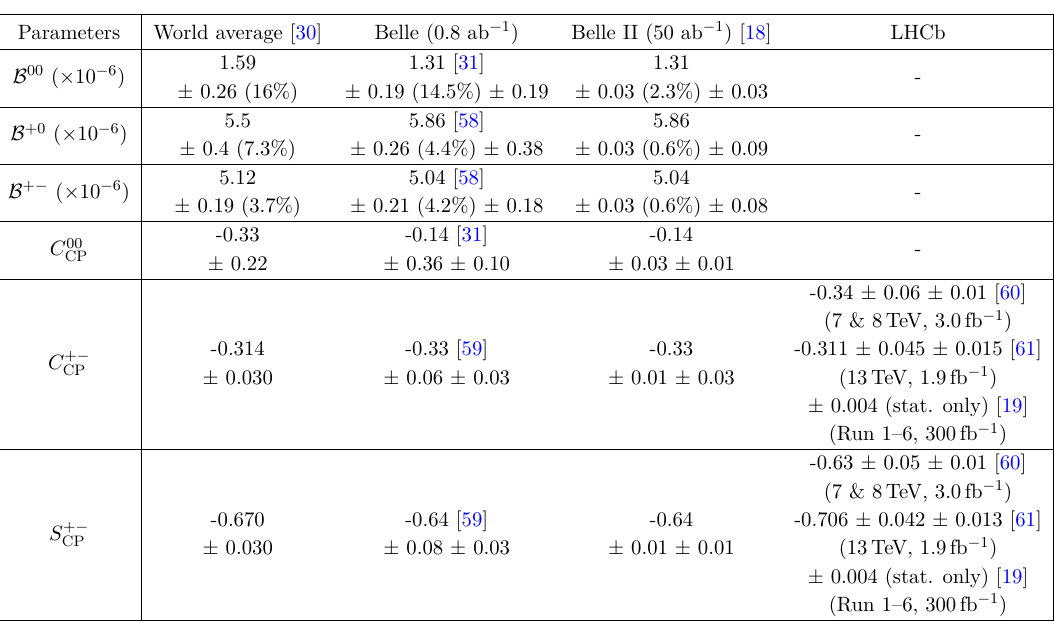
Table 6 . Six input parameters currently used to determine the CKM angle α via B → ππ modes. The percentages in parentheses represent the relative statistical uncertainties of the three